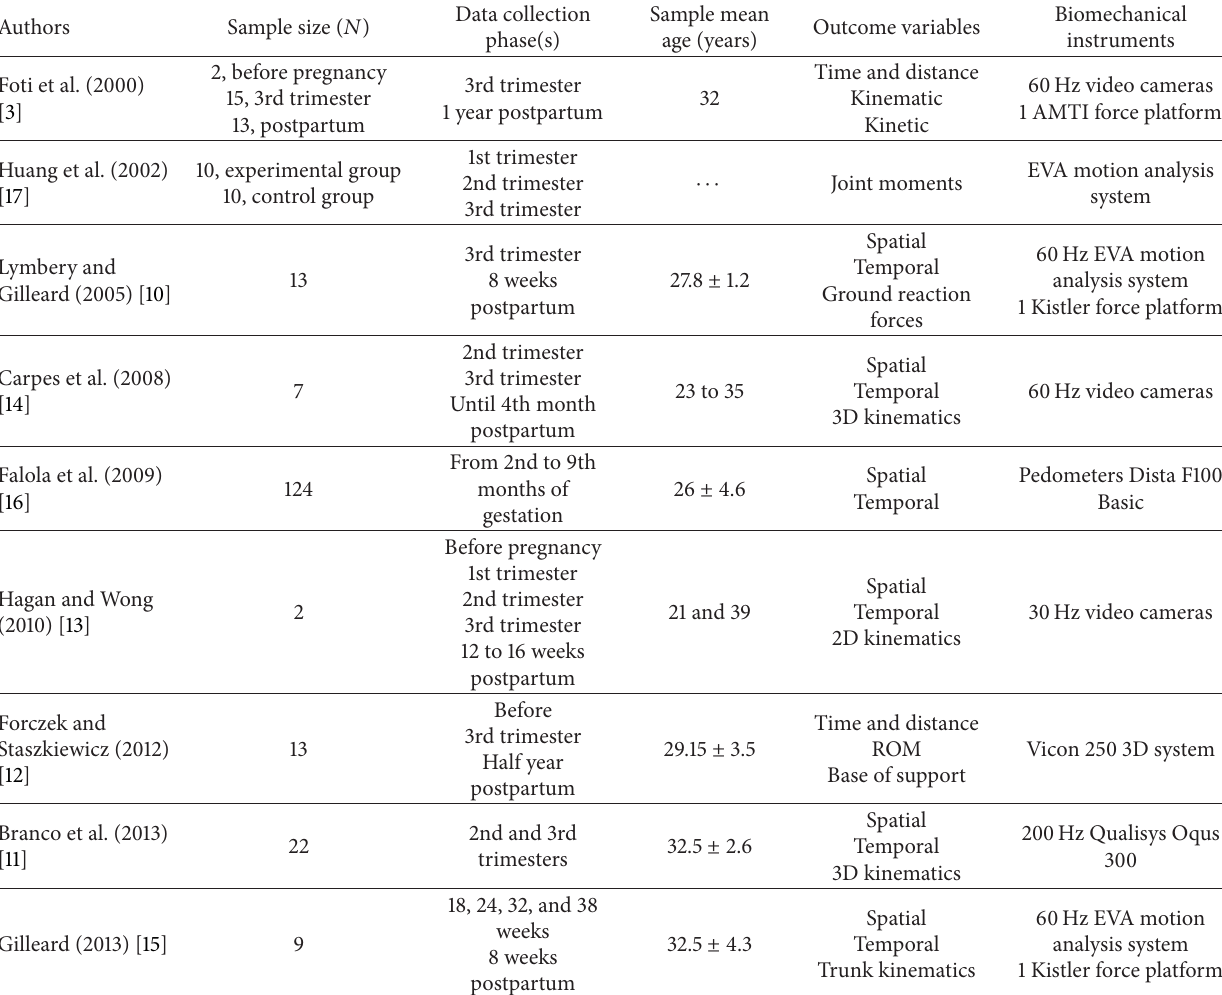
Table 1: Studies included in the review, listed by chronological order of publication, regarding authors, sample size, data collection phases, sample mean age, outcome variables, and biomechanical instruments